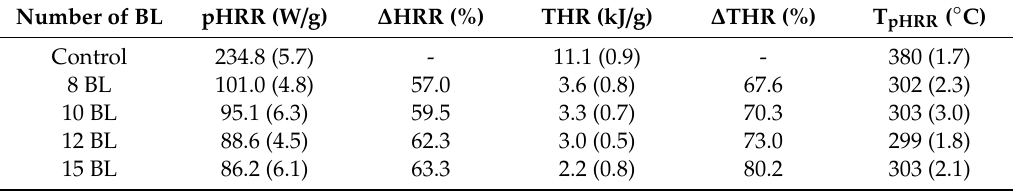
Table 3. Heat release values of layer-by-layer (LbL) treated cotton fabric (with standard